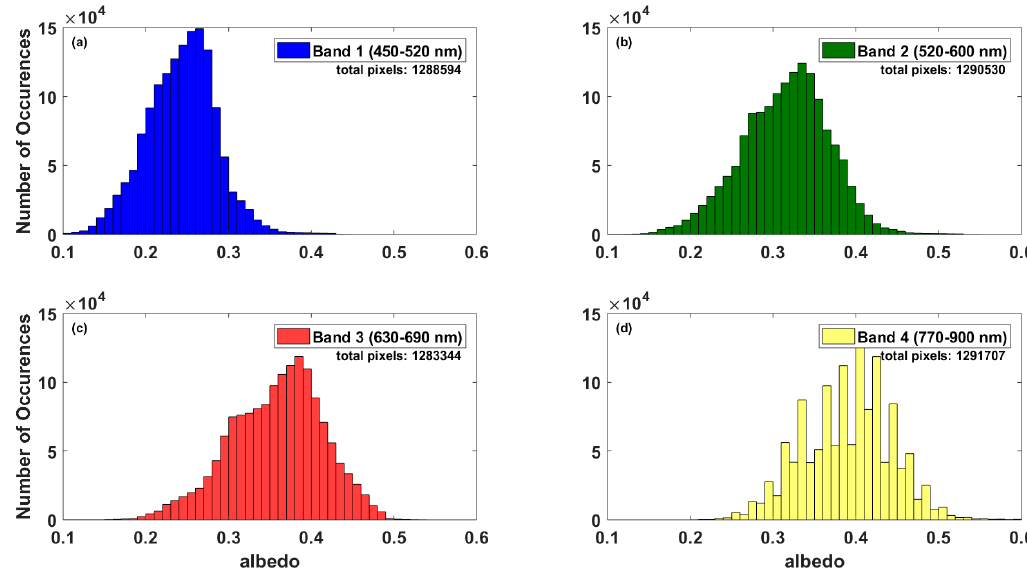
Figure 15. Histogram of all LANDSAT7 ETM+ pixels over Nevada’s Black Rock Desert on 5 October 2017. ( a ) Band 1 (450–520 nm). ( b ) Band 2 (520–600 nm). ( c ) Band 3 (630–690 nm). ( d ) Band 4 (770–900 nm).